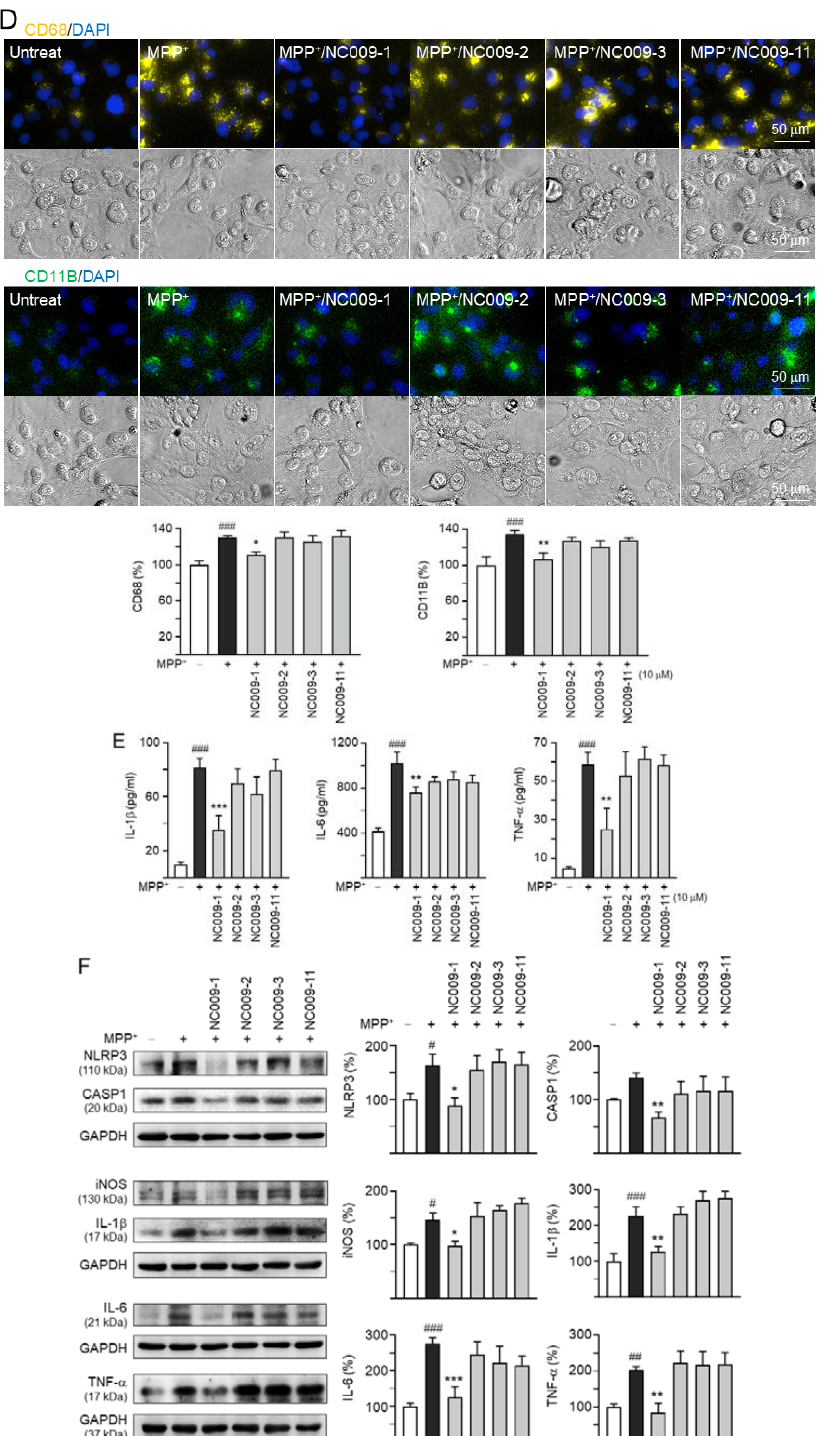
Figure 2. MPP + -induced inflammation of HMC3 microglia and anti-inflammatory potentials of NC009 compounds. ( A ) Cytotoxicity of MPP + against HMC3 cells by MTT and NO release assays. Cells were treated with MPP + (0–10 mM) and cell viability and NO release in culture medium was measured the following day ( n = 3). To normalize, the relative cell viability in MPP + -untreated (inactive) cells was set at 100%. p values: comparisons between inactive and activated cells (* p < 0.05, *** p < 0.001). ( B ) Experimental flow chart. HMC3 cells were plated on day 1. Af- ter 20 h, cells were pre-treated with test compounds (1–10 µ M) for 8 h, followed by MPP + (3 mM) treatment for 20 h. On day 3, the HMC3 cells were examined for cell viability (MTT assay) and